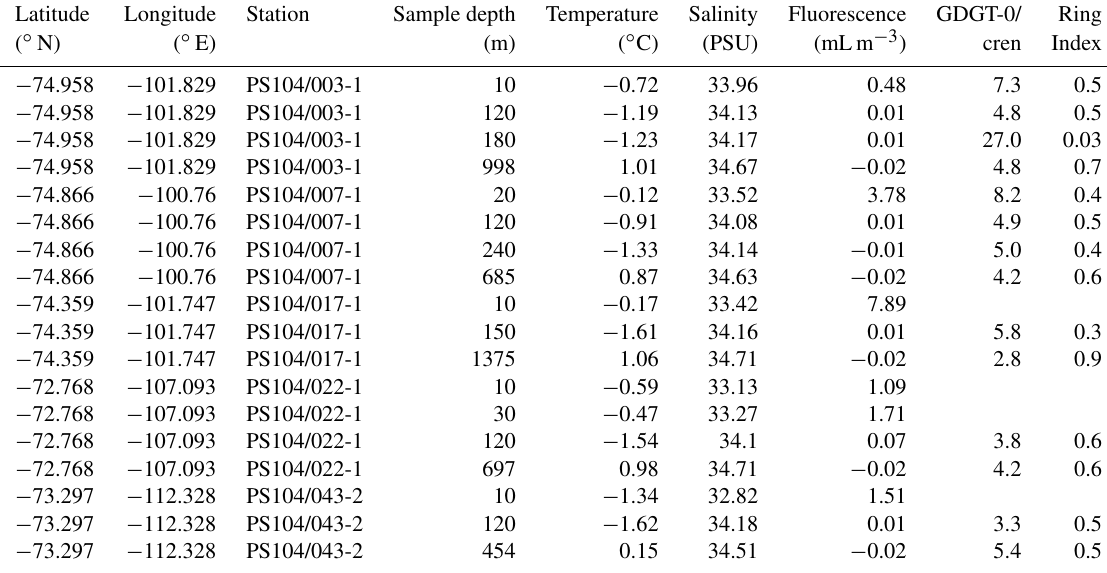
Table 2. Amundsen Sea SPM samples studied and their physical properties, GDGT-0 / cren, and Ring Index. Latitude Longitude Station Sample depth Temperature Salinity Fluorescence GDGT-0/ Ring ( ◦ N) ( ◦